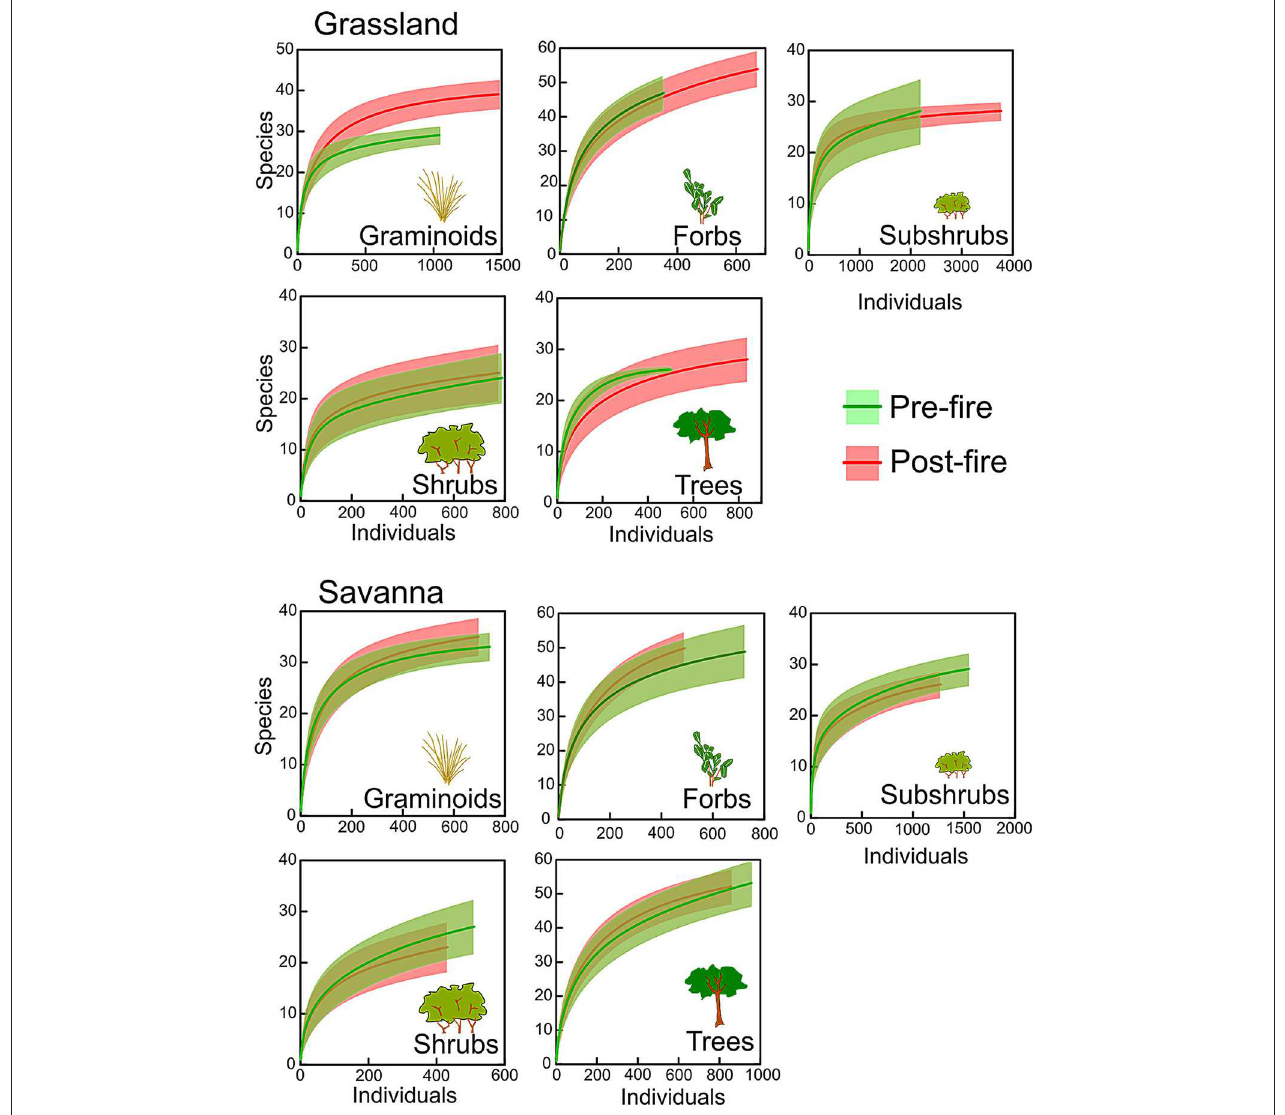
FIGURE 1 | Individual-based rarefaction curves (with 95% confidence intervals) comparing species richness of different plant groups between the unburned (green) and burned plots (red) in grassland and savanna vegetation types, at Santa Bárbara Ecological Station, state of São Paulo,